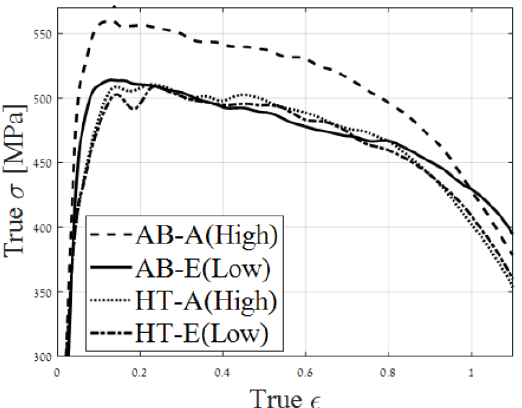
Fig. 2 True-strain true-stress curve obtained from the SHPB